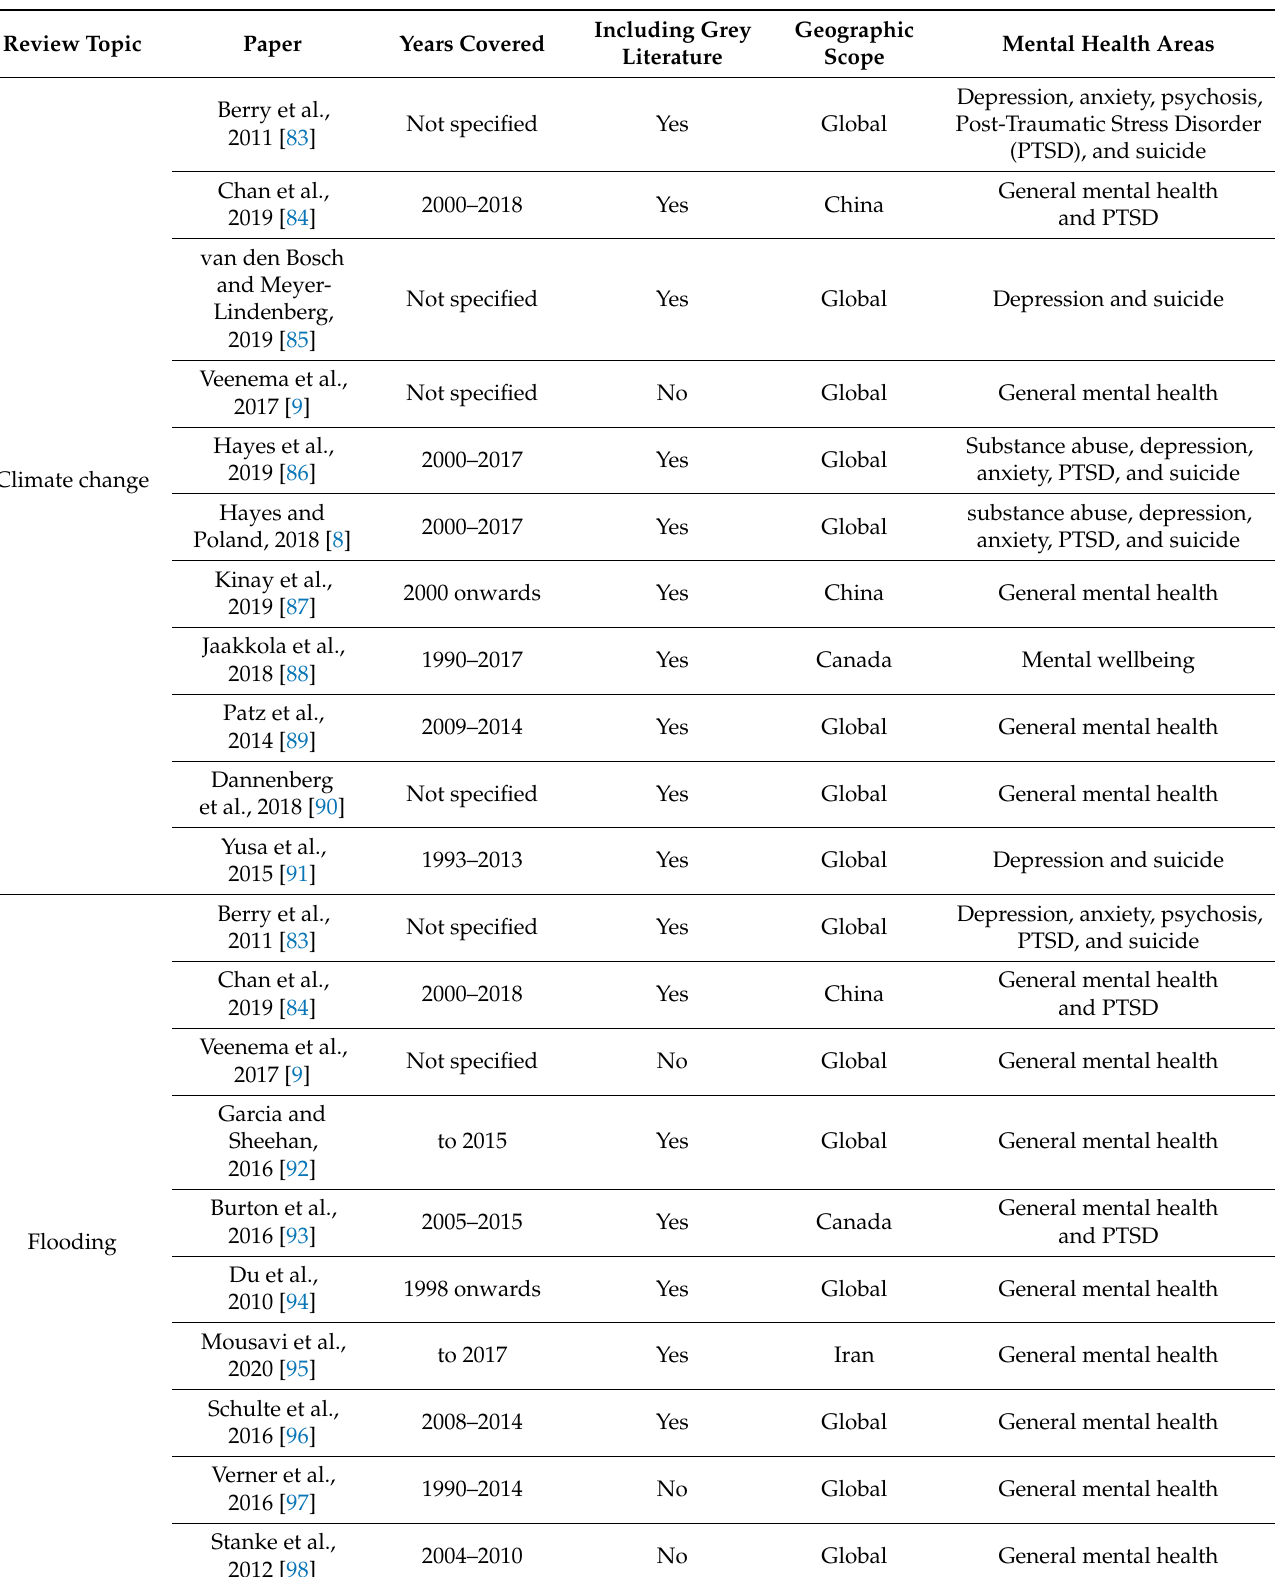
Table 6. Scope of research covered by review papers on climate change, flooding, air pollution, and urban green